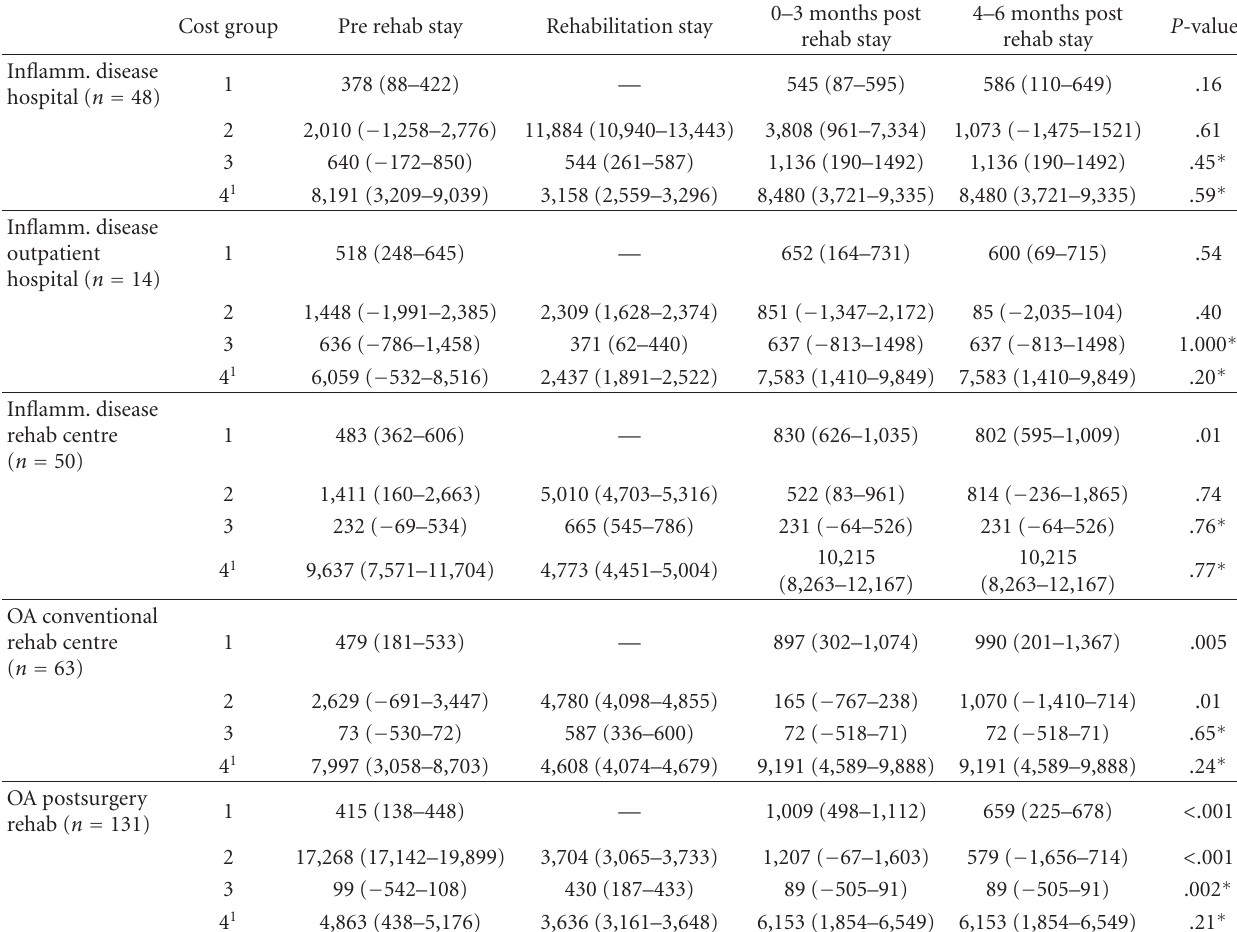
Table 3: Mean costs in Euro (C) with 95% Confidence Intervals B 3 months prior to, during, and 6 months after multidisciplinary rehabilitation in various clinical subgroups; the costs are presented according to the four cost